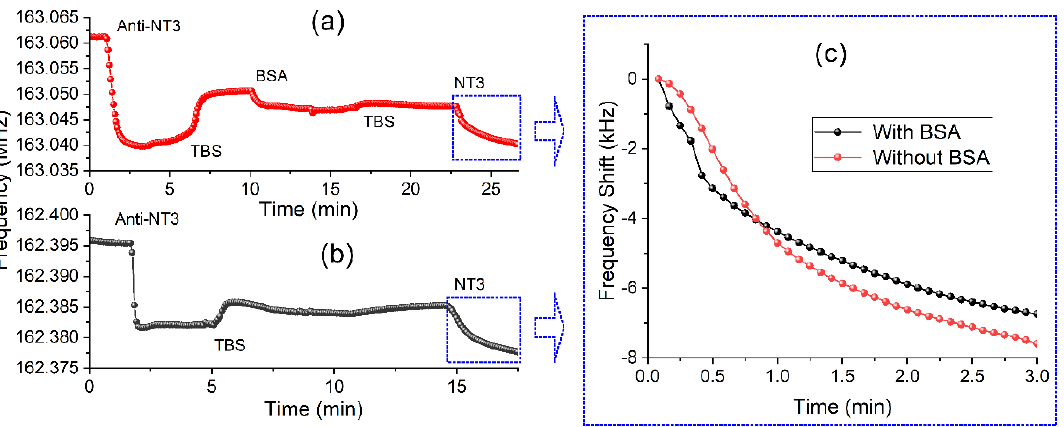
Figure 4. ( a ) Complete sensing process for NT-3 (50 μ g/mL) with BSA. ( b ) Complete sensing process for NT-3 without BSA. ( c ) Comparison of frequency shift for both processes.